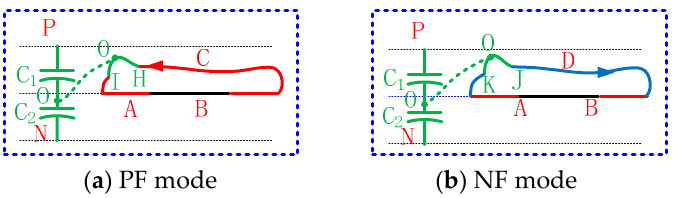
Figure 4. Direct Connection of Unified NPC cell under USPWM. ( a ) PF mode; ( b ) NF mode.